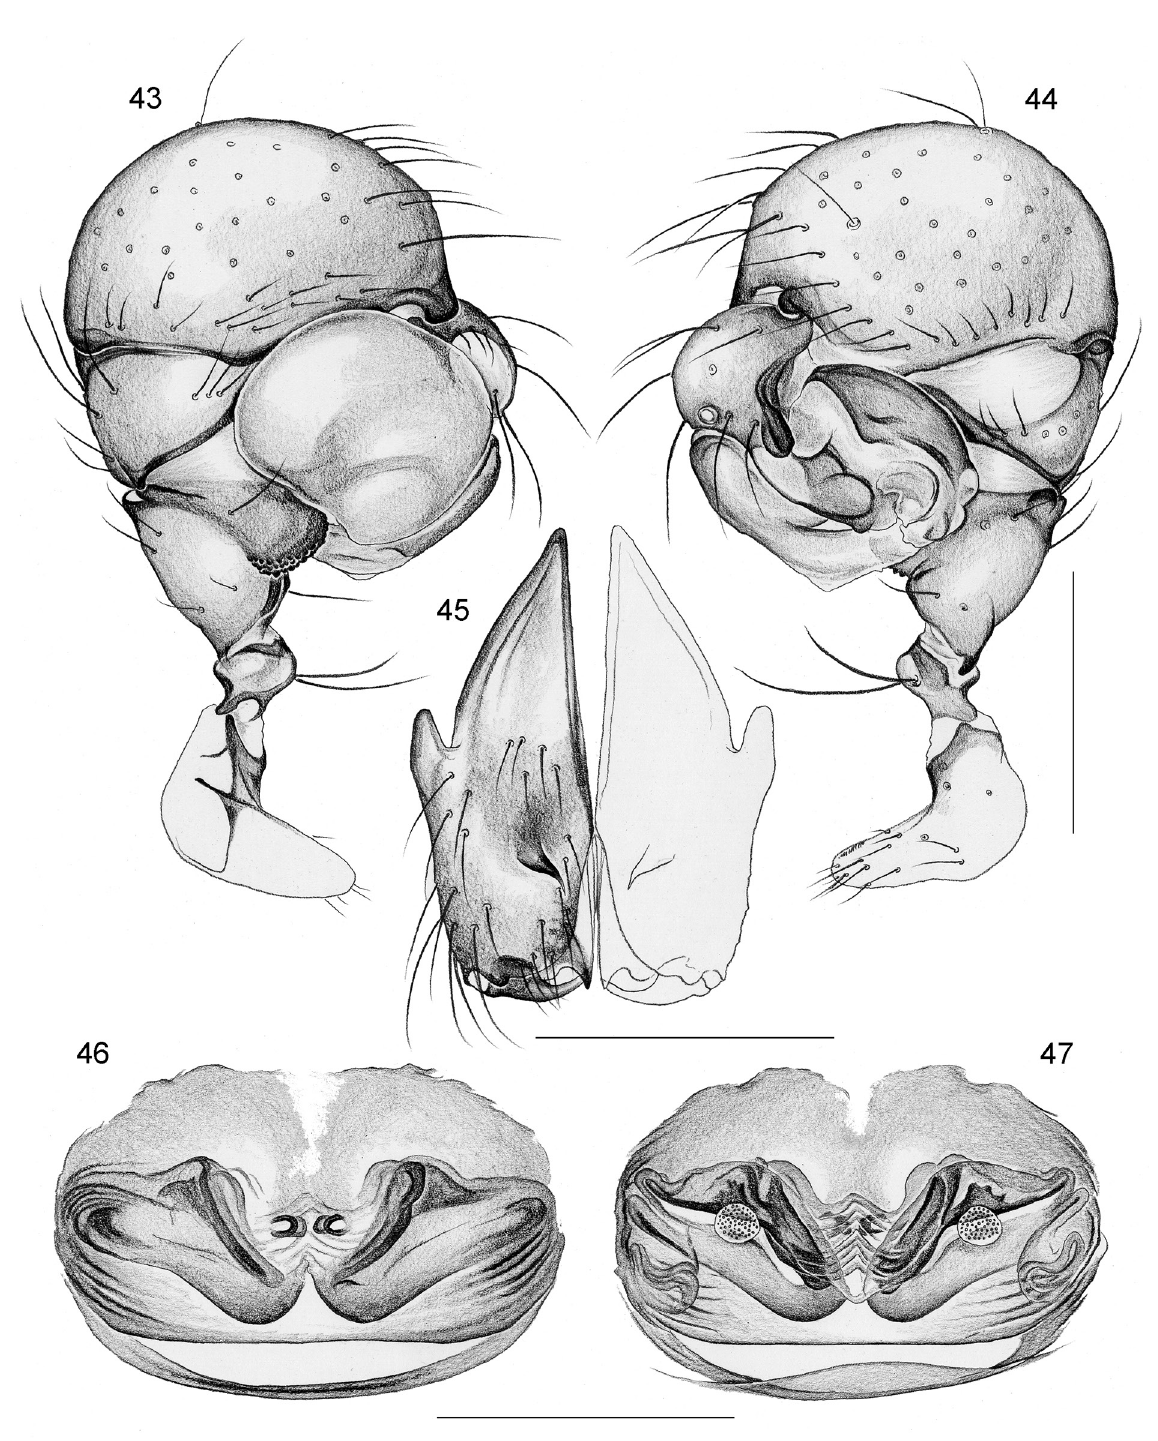
Figs 43-47. Anansus atewa sp. nov. 43-44 . Left ♂ palp, prolateral and retrolateral views. 45 . ♂ chelicerae, frontal view. 46-47 . Cleared ♀ genitalia, ventral and dorsal views. Scale lines: 43-44, 46-47 = 0.3 mm; 45 = 0.2